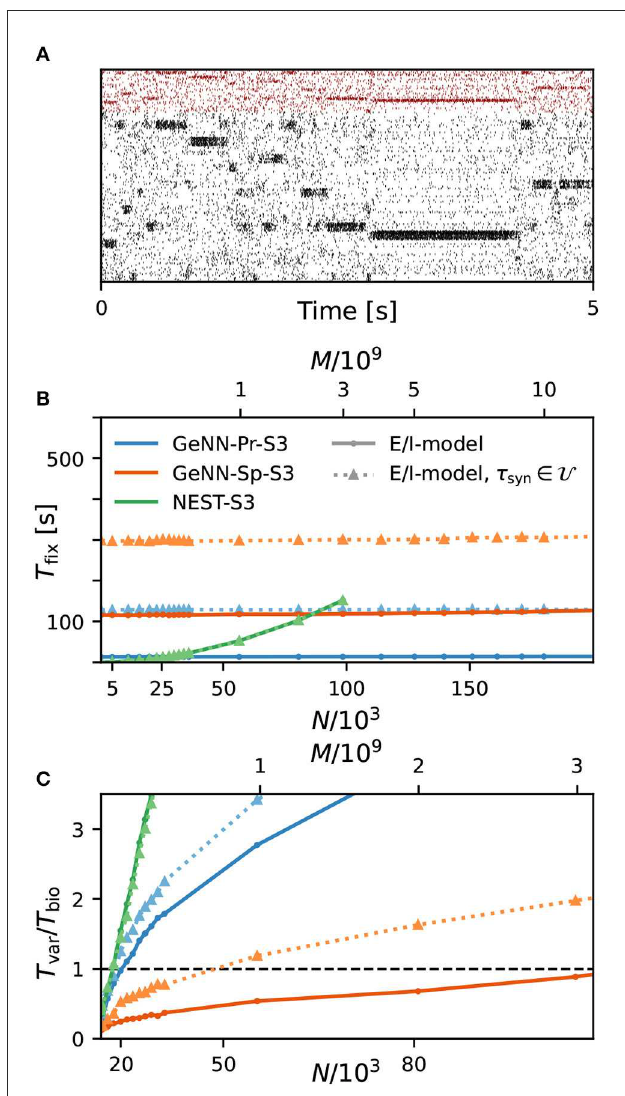
FIGURE4 Metastability and simulation costs for networks with heterogeneous synaptic time constants. (A) Raster plot of excitatory (black) and inhibitory (red) spiking activity in a network of N = 25,000 neurons with heterogeneous synaptic time constants during 5 s of spontaneous activity shows the desired metastable behavior where different individual clusters can spontaneously assume states of high and low activities. A portion of 8% of neurons from each of the 20 clusters is shown. Network parameters are identical to Figure 1D: J E + = 2.75, I thE = 1.6, and I thI = 0.9. The spike raster plot is generated from a GeNN simulation. (B) Total fixed costs in dependence of network size for the E/I model with (dotted lines) and without (solid lines) distributed synaptic time constants when simulated with NEST (green) or GeNN. For NEST, the fixed costs are indistinguishable for both model variants. For GeNN, the fixed costs are independent of network size but considerably higher with distributed synaptic time constants. (C) Real-time factor in dependence of network size. For NEST, the variable costs are the same in the case of homogeneous and heterogeneous synaptic time constants, while GeNN has increased variable costs in the heterogeneous case. Note that the x-axis in (B) is linear in N , while the x-axis in (C) is linear in M .